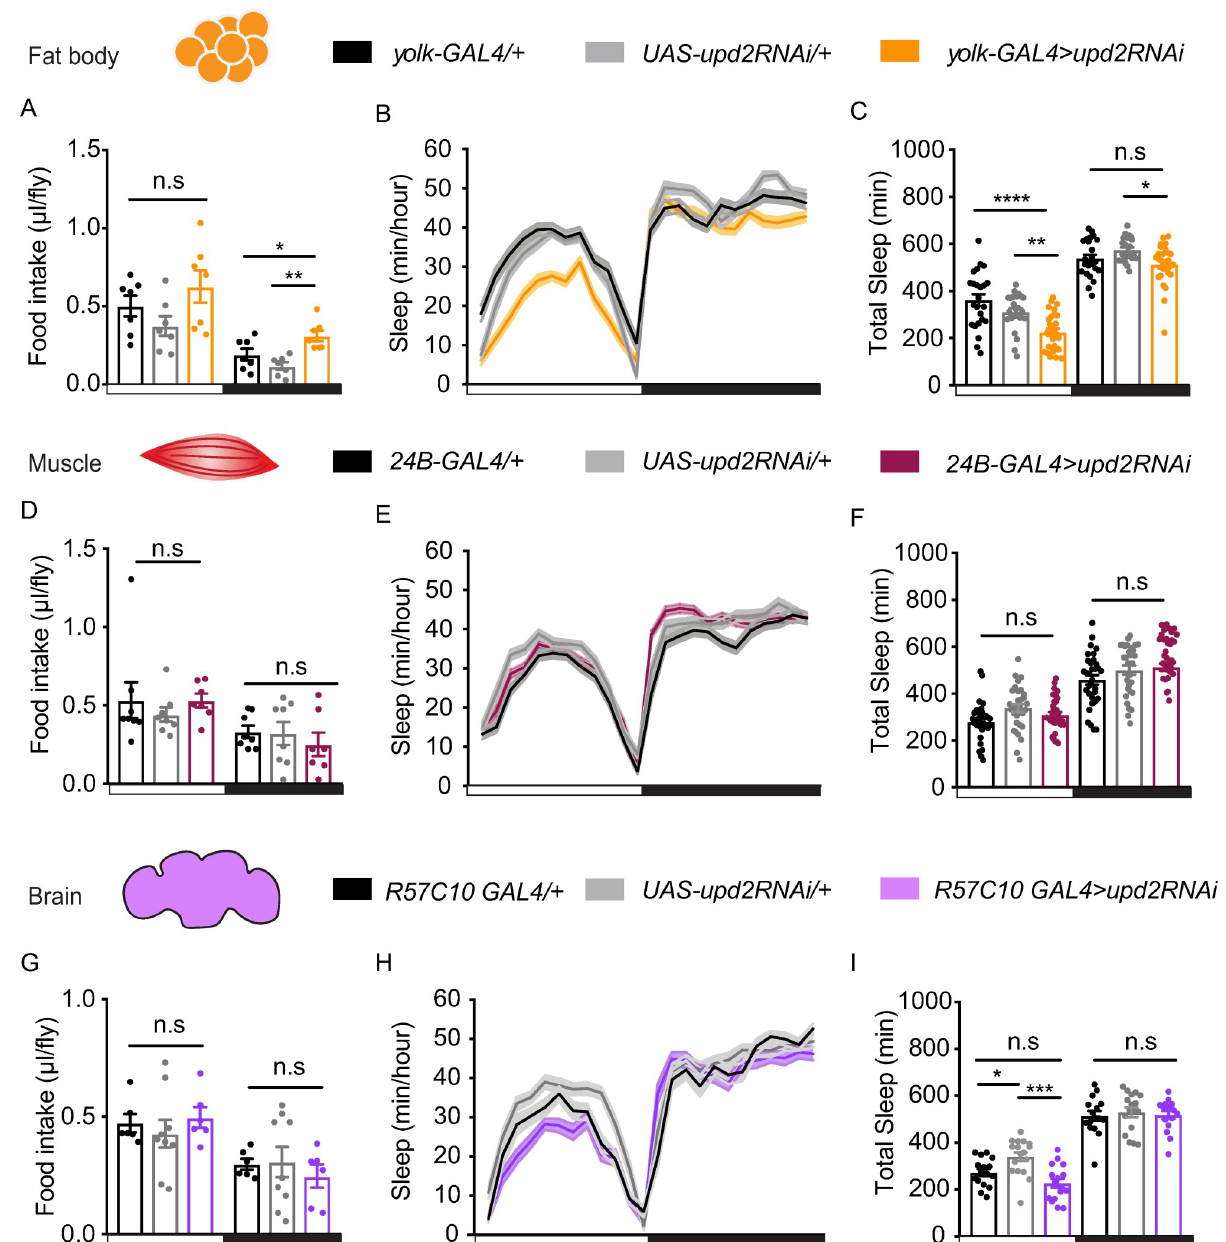
Fig 2. upd2 expression in the FB is required for sleep and feeding regulation. (A) Daytime feeding (left panel, white) in flies with FB upd2 knockdown (orange) was similar to genetic controls; yolk-GAL4/+ (black) and UAS-upd2RNAi/+ (gray). Nighttime feeding (right panel, black) was significantly increased in knockdown flies. (B) The 24-hour sleep profile of flies with upd2 knockdown (orange line) compared with parental controls (black, yolk-GAL4/+ ; gray, UAS-upd2RNAi/+ ) (mean ± SEM, n = 24–28 per genotype). (C) Sleep duration in knockdown flies was significantly reduced during the day against both controls. Nighttime sleep was only reduced compared with UAS-upd2RNAi/+ . (D) Muscle-specific knockdown of upd2 by using 24B-GAL4 (maroon) did not alter day or nighttime food intake or (E-F) sleep duration. (G) Knockdown of upd2 pan-neuronally using R57C10-GAL4 (purple) also had no effects on food intake or (H-I) on sleep ( n = 16–17). One-way ANOVA (with Tukey’s post hoc test) for normally distributed data or Kruskal-Wallis test (with Dunn’s multiple comparison test) for nonparametric data was used to compare data sets. � P < 0.05, �� P < 0.01, ��� P < 0.001; error bars show SEM. White and black bars indicate day and night, respectively. In A, D, and G, n = 5 flies per data point (chamber). The data underlying this figure can be found in S1 Data. FB, fat body; GAL4, galactose-responsive transcription factor; RNAi, RNA interference; UAS, upstream activation sequence; upd2 , unpaired